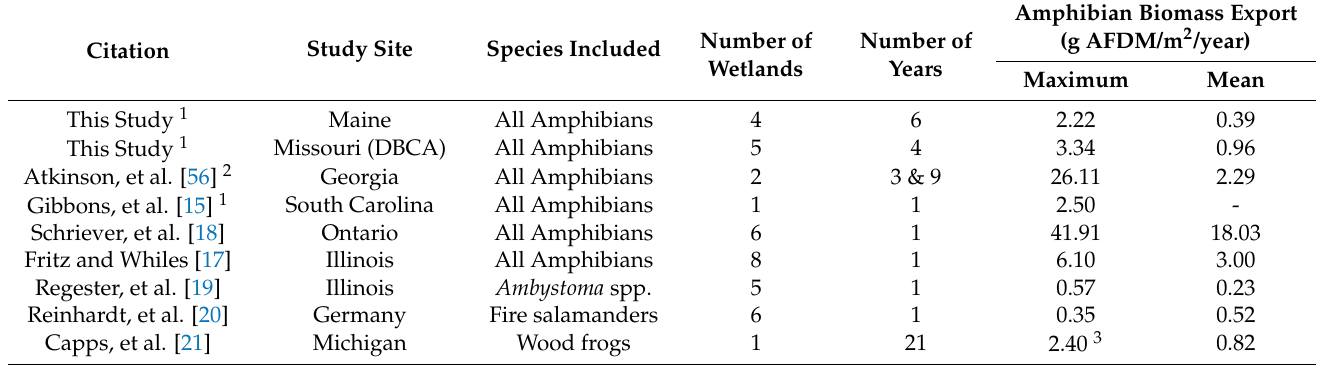
Table 4. Comparison of amphibian biomass export per wetland per